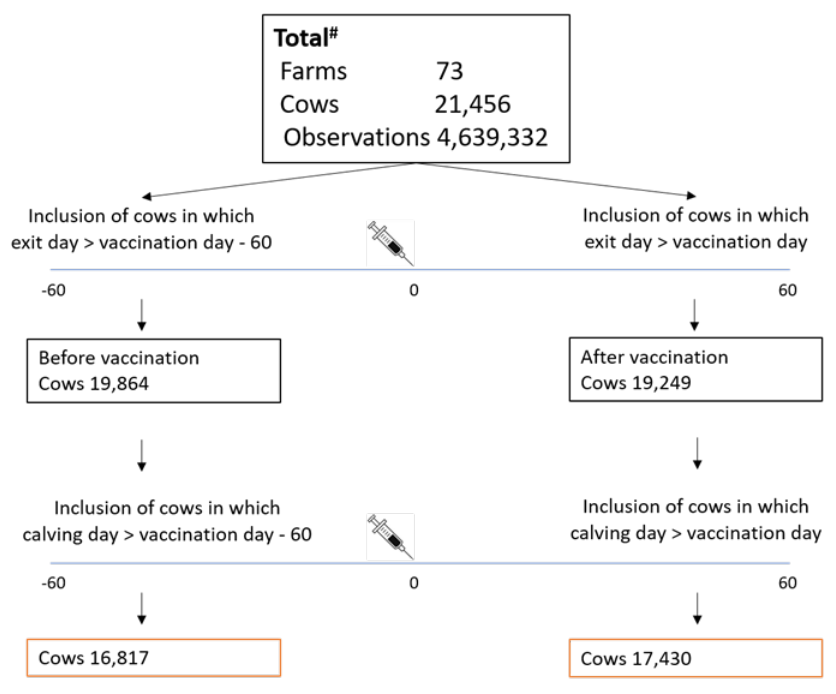
Figure 2. Overall number of observations and cows available for survival analysis in each lactation group in 73 farms.